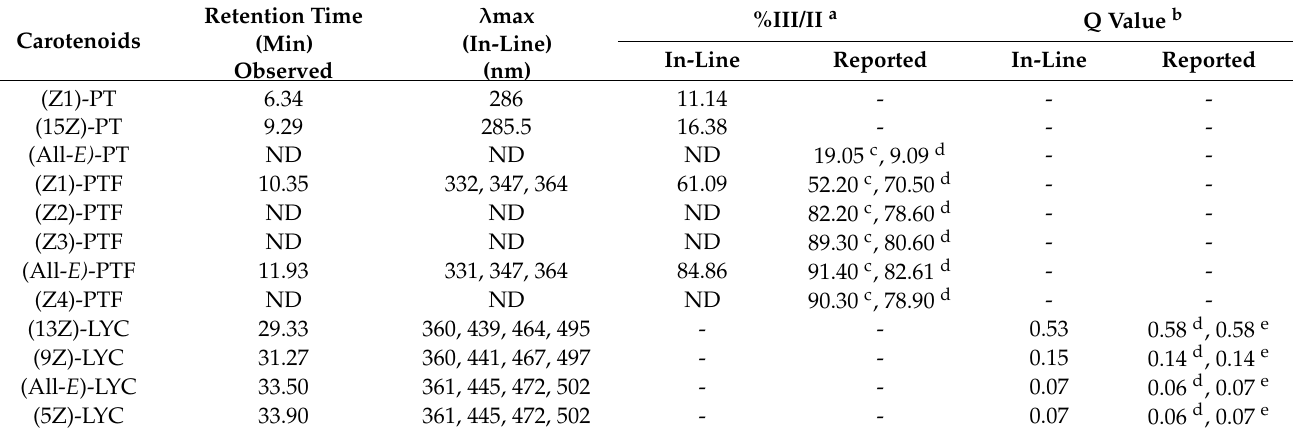
Table 1. Identification of PT, PTF and LYC